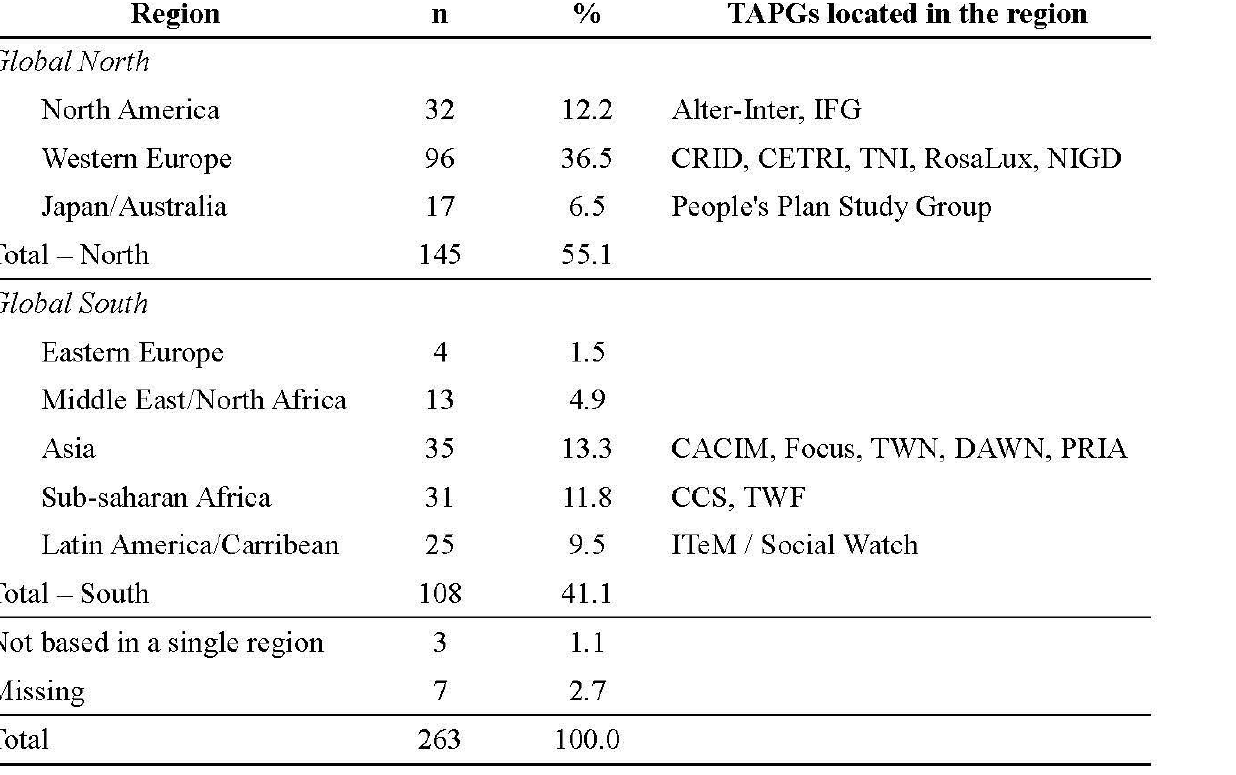
Table 5. Regional distribution of TAPGs and neighboring INGOs Region n O/o TAPGs located in the region Global North North America 32 12.2 Alter-Inter,